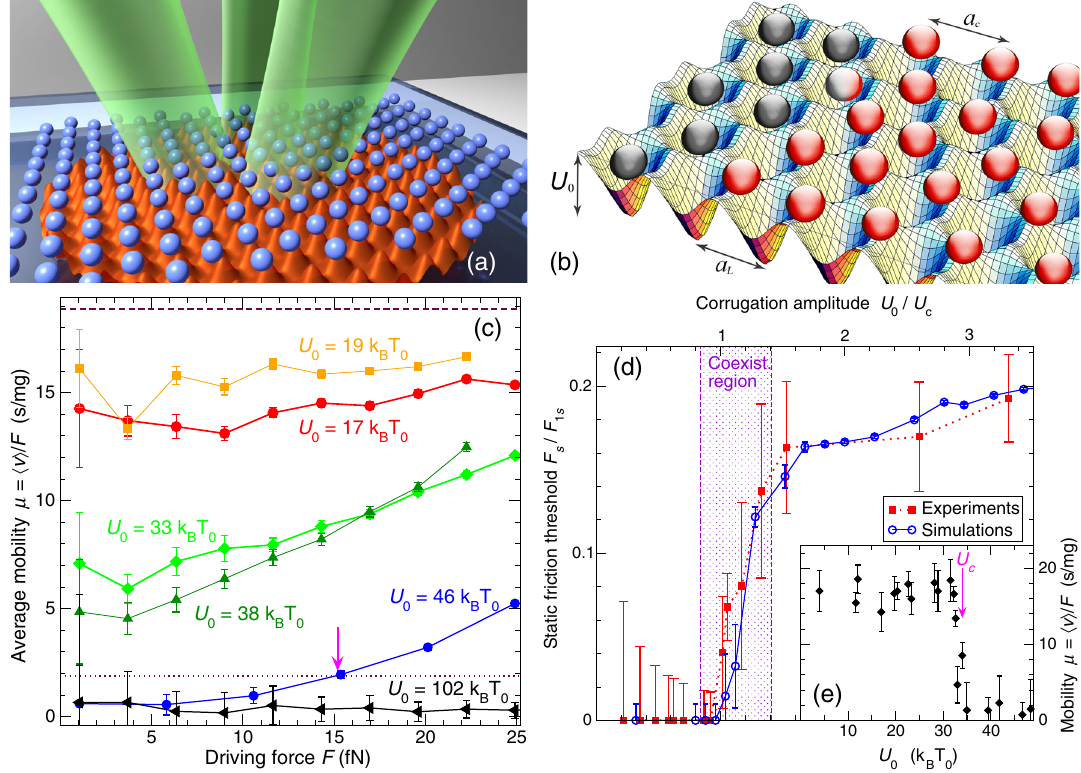
FIG. 1. Driving a colloidal monolayer across a periodic laser potential. (a) Schematic view of the experimental setup. (b) Corresponding simulated model. (c) Measured mobility of an incommensurate ( ε ¼ 0 . 84 ) monolayer vs driving force for different corrugation amplitudes U 0 in the superlubric (red and orange symbols), coexistence (green symbols), and statically pinned phase (blue and black symbols). The dashed line shows the maximum mobility ( U 0 ¼ 0 ), while the dotted line shows the minimum threshold mobility to detect sliding. The pink arrow points at the crossing of this threshold mobility, defining the value of F s for this value of U 0 . (d) Static friction force F s vs U 0 obtained from experiments (solid symbols) and simulations (open symbols); the shaded area shows the coexistence region, across which Aubry transition takes place. (e) The monolayer mobility under the action of the smallest ≃ 1 fN; the critical corrugation U ¼ 34 k T experimentally accessible driving force F c B 0 is defined by the sharp drop in the min mobility